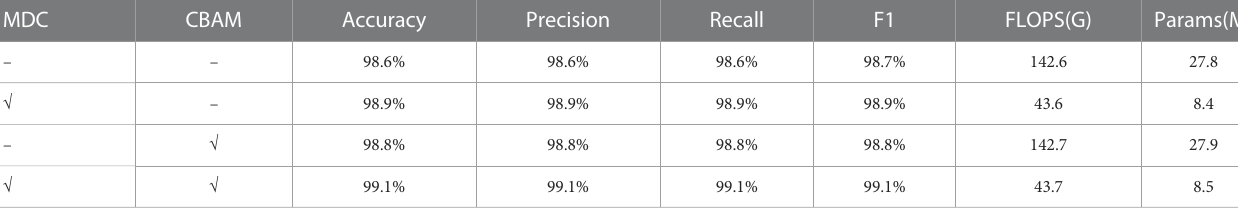
TABLE 4 Comparison of ablation experiments on the test set. MDC CBAM Accuracy